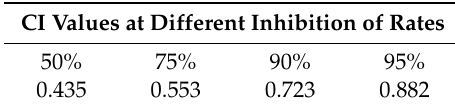
Table 2. The CI numbers of combined BA and Rh 2.